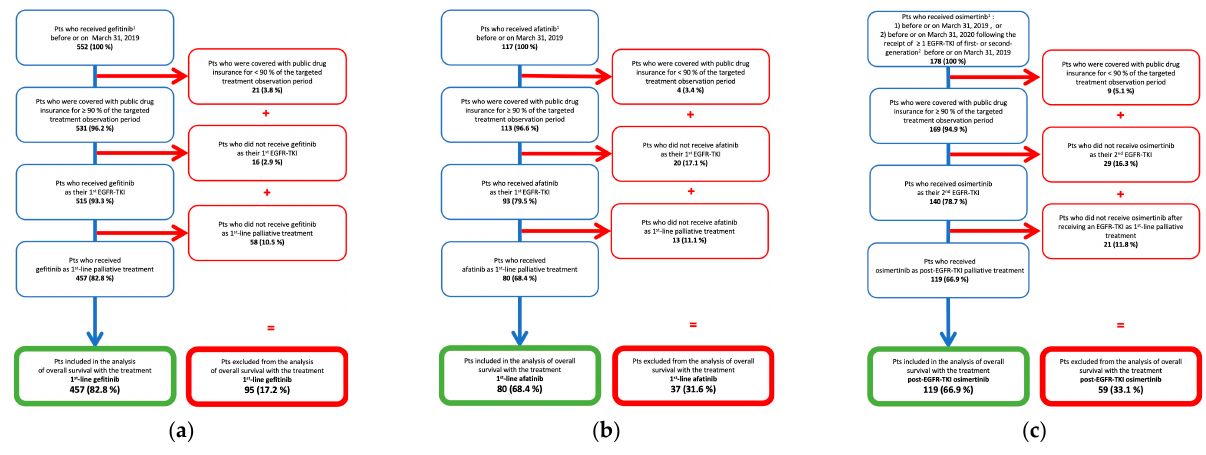
Figure 1. Flowchart of study populations in EGFR ‐ TKI cohorts: ( a ) 1st ‐ line gefitinib cohort; ( b ) 1st ‐ line afatinib cohort; ( c ) Post ‐ EGFR ‐ TKI osimertinib cohort. Abbreviations : Pts: Patients. 1 End of follow ‐ up: 31 March 2020. 2 Gefitinib, afatinib, or erlotinib.